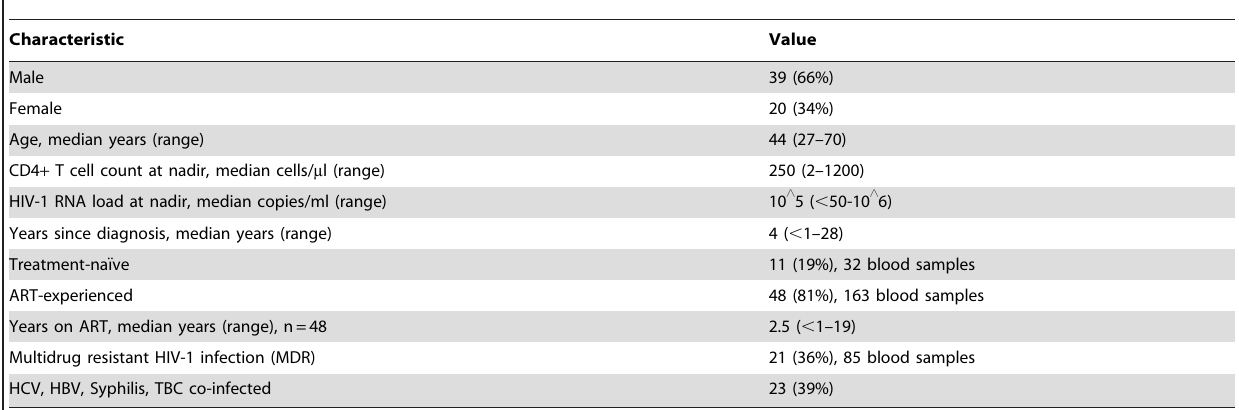
Table 1. Clinical characteristics of the patients.